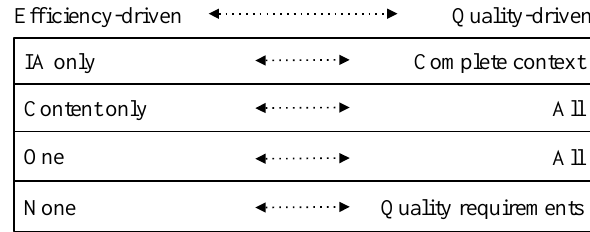
Figure 2. Connection Strategy.